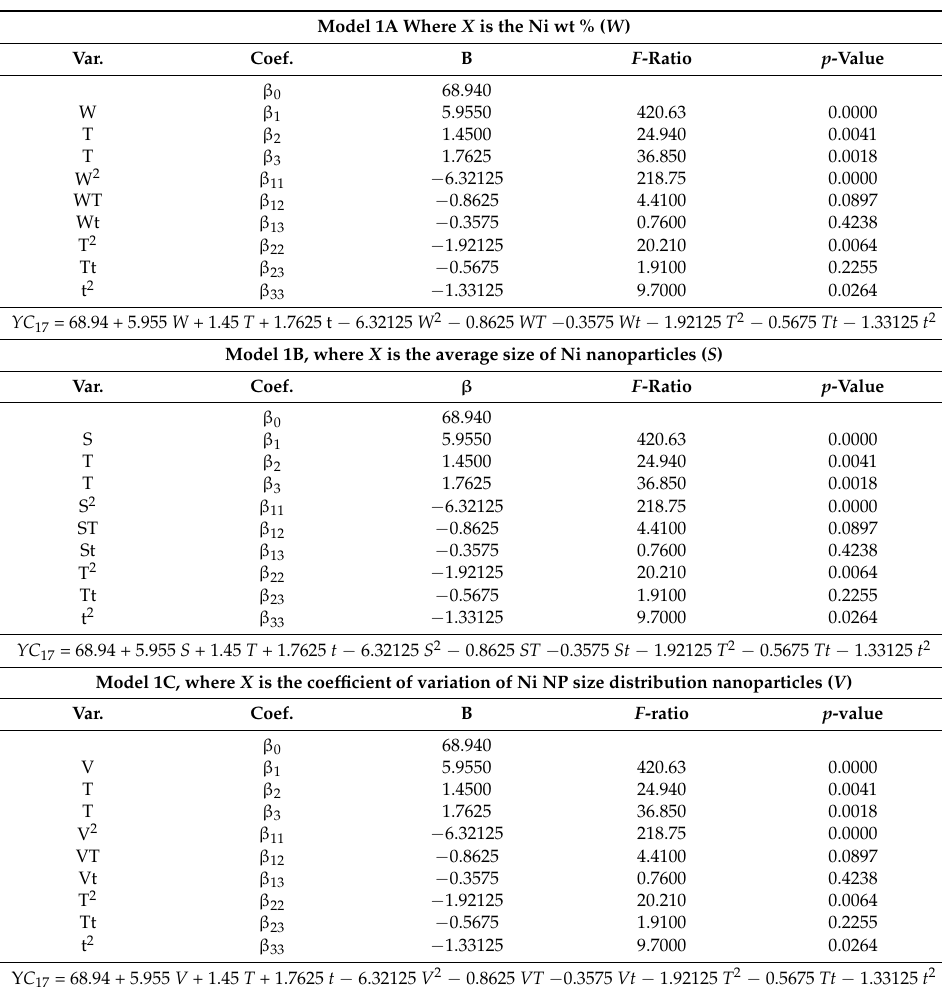
Table 4. Statistical coefficients for n-C 17 yield (mol %) and their statistical